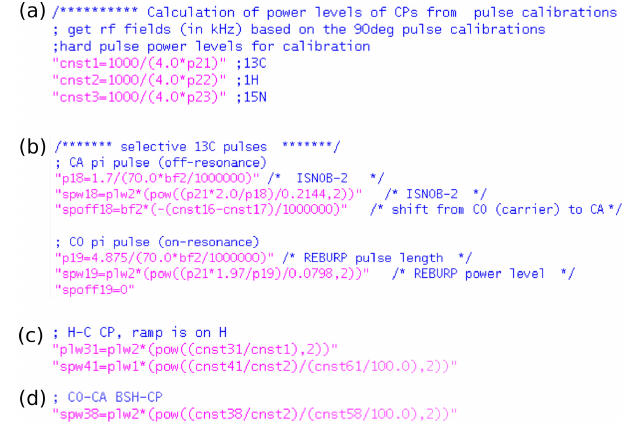
Figure 4. Calculation of RF pulse parameters in ssNMRlib se- quences for spectrometer-frequency independent setup. (a) The hard pulses ( p21 , p22 , p23 ) are translated to RF field strengths in kilohertz ( cnst1 , cnst2 , cnst3 ). (b) Calculation of selective- pulse parameters exemplified for off-resonance ISNOB2 and an on- resonance REBURP shape, using 70ppm excitation bandwidth, at a spectrometer operating at a frequency of bf2 (in MHz). The values of cnst16 and cnst17 represent the centres of the CO and CA fre- quency bands, respectively, in ppm units. (c) Calculation of power levels of a cross-polarization, here for a 1 H − 13 C transfer with an amplitude ramp on the 1 H channel. The desired RF field values in kHz in the middle of the ramp are specified in cnst31 (for 13 C) and cnst41 ( 1 H); the additional cnst61 corresponds to the percentage value of ramp in its centre, e.g. cnst61 = 85 for a ramp that goes from 70% to 100%. As the power level of the ramp corresponds to the highest value of the ramp, this constant is needed for the calcu- lation, in addition to the midpoint RF field strength. (d) Calculation of amplitude for a ramped transfer on one channel, such as DREAM or BSH-CP. The RF field strength at the midpoint of the ramp cor- responds to cnst38